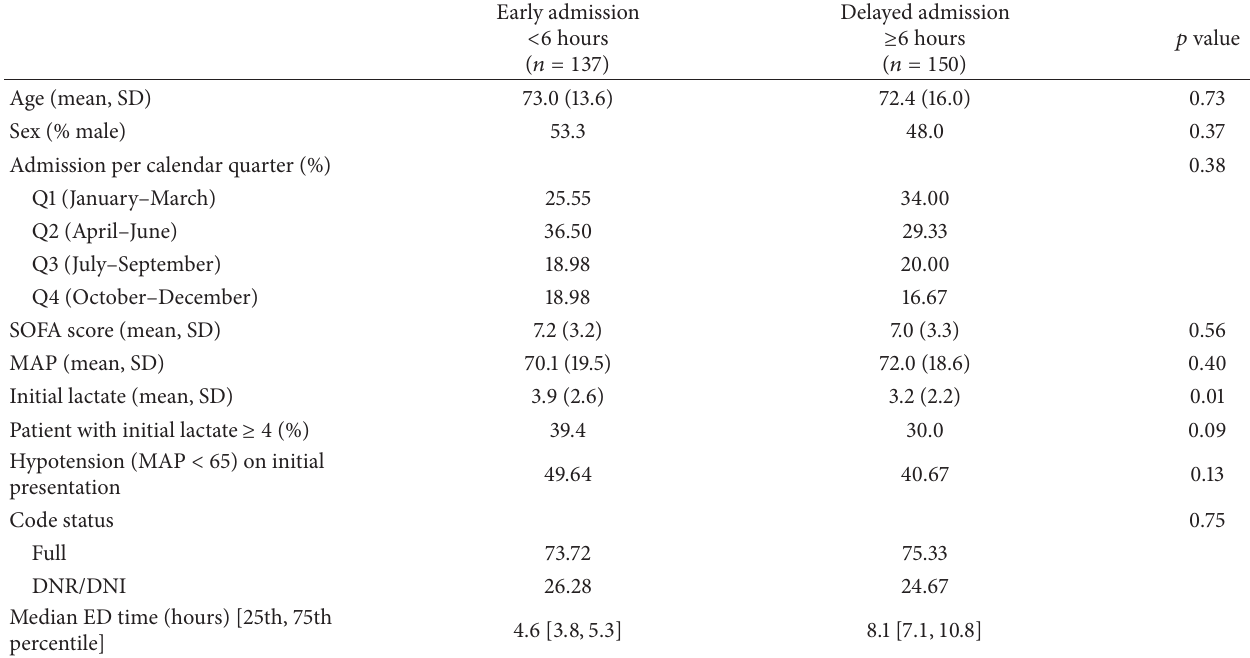
Table 1: Demographics and baseline characteristics for early and delayed ICU admission (𝑛 = 287) .